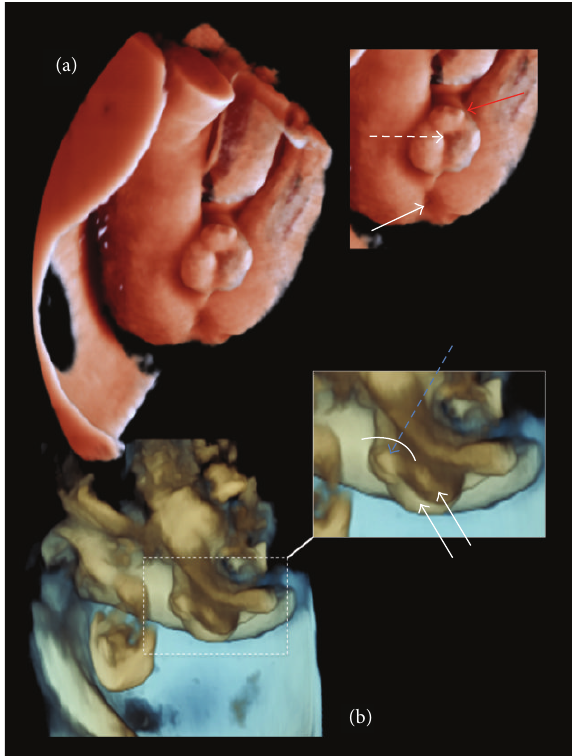
Figure 2: Three-dimensional representation of the genital surface. The configuration of the penis and its anatomical relations is shown in ample detail. (a) It is possible to detect the urethral meatus in the base of the penis (dashed arrow) and the surplus prepucial tissue at the tip forming the cap (red continuous arrow). We can also notice its relation with the perineum (the continuous arrow points to the anus). (b) In the transversal view it is possible to see the shortened penis (blue dashed arrow) with the chordee (curved line) and the surplus foreskin. We can also observe the two scrotal folds with both testicles inside (double